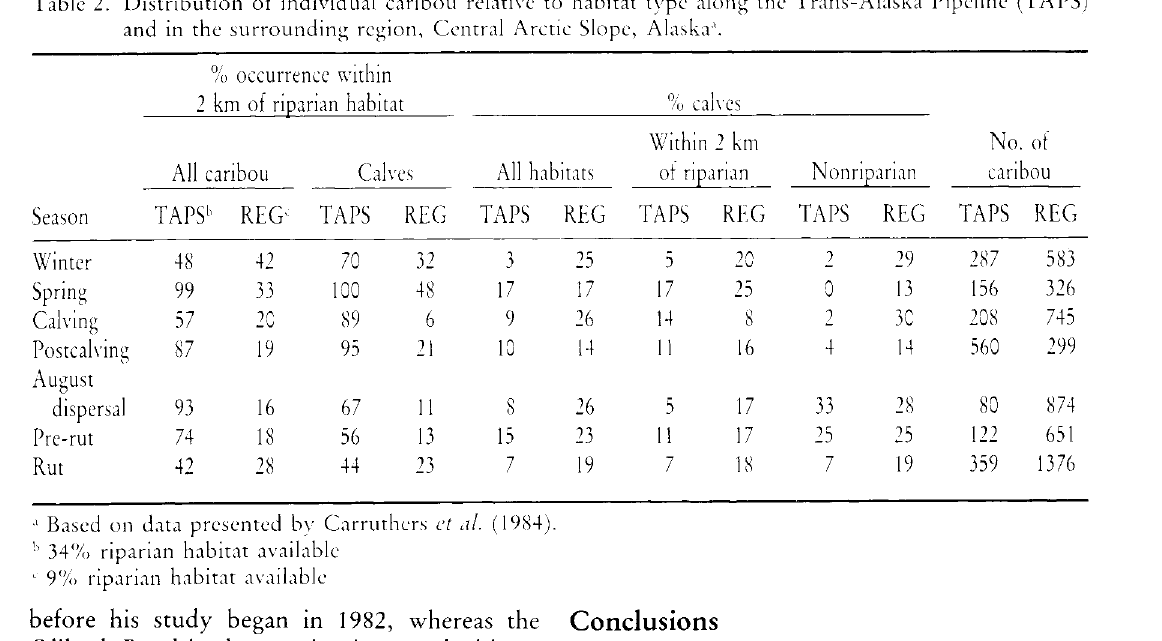
Table 2. Distribution of individual caribou relative to habitat type along the Trans-Alaska Pipeline (TAPS) and in the surrounding region, Central Arctic Slope, Alaska 1